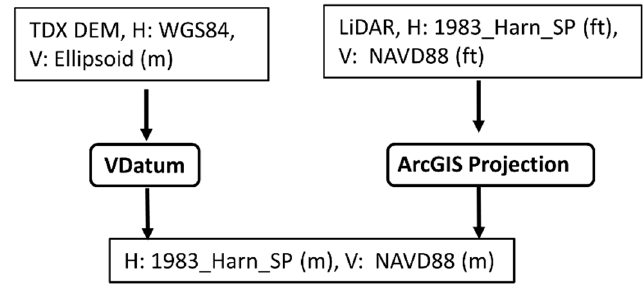
Figure 2. Flowchart for datum conversion.